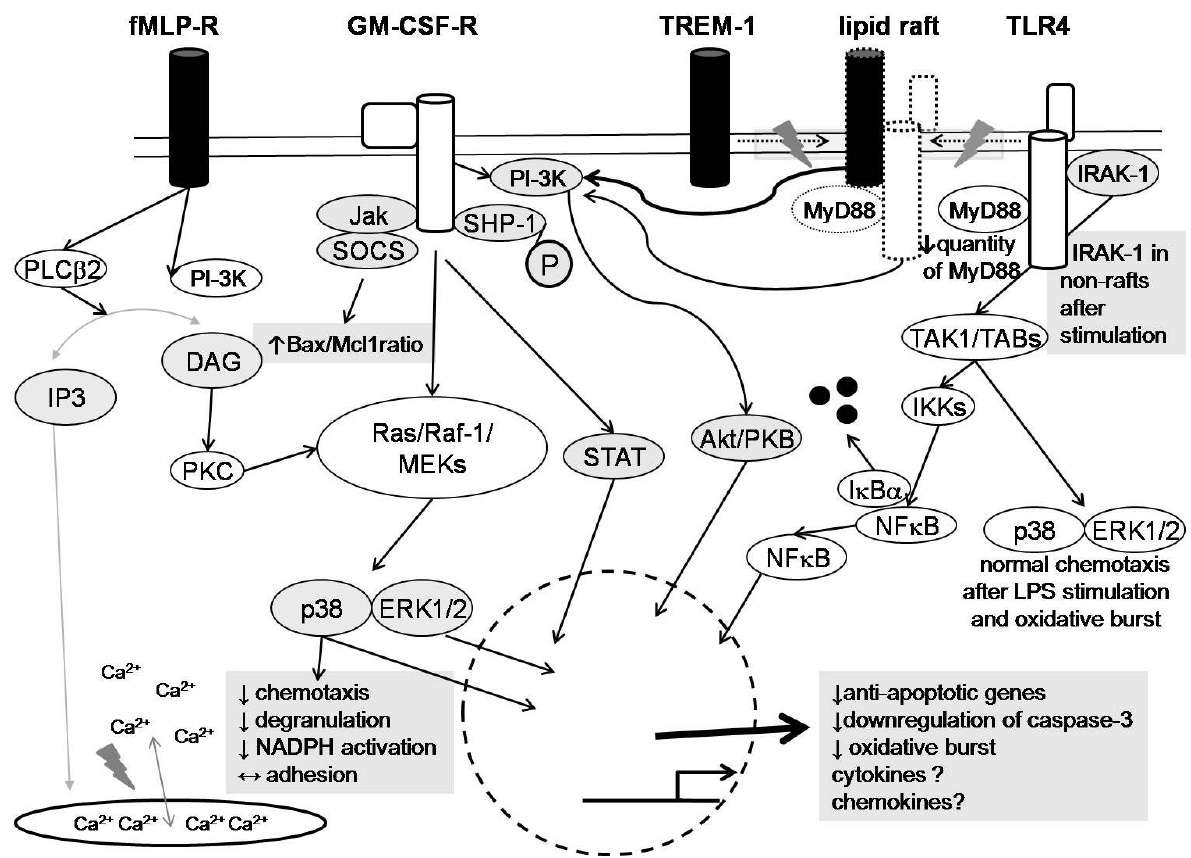
FIGURE 2. Signaling in neutrophils of the elderly. Age-related impairment in intracellular signaling after binding of the appropriate ligands to their receptors explains the functional changes in PMN of aged subjects. Molecules with gray background display defects in the signaling cascade associated with age. Translocation of TREM-1 and TLR4 into LR is indicated by dashed lines. Interestingly, signaling induced by ligands of fMLP-R, GM-CSF-R, and TREM-1 is mostly disturbed, while the majority of TLR4-mediated signaling remains intact throughout aging. (Modified and adapted from Uciechowski and Rink[39].) PLC, phospholipase C; DAG, diacylglycerol; IP3, inositol triphosphate; MEK, MAPK (mitogen-activated protein kinase)/ERK kinase; ERK, extracellular signal-regulated kinase; PKC, protein kinase C; PI-3K, phosphoinositide-3 kinase; TREM-1, triggering receptor expressed on myeloid